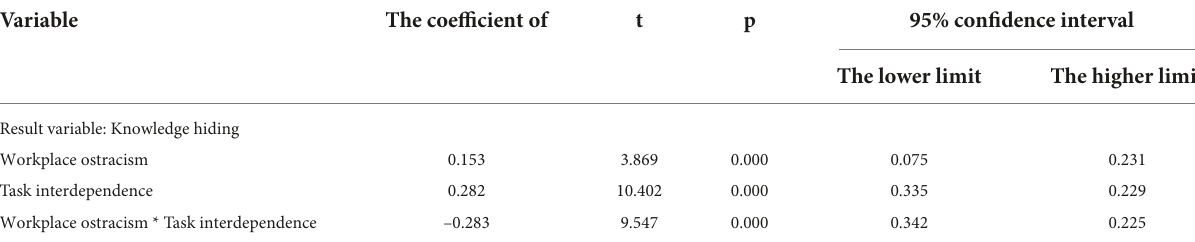
TABLE 6 Test results of moderating effect.